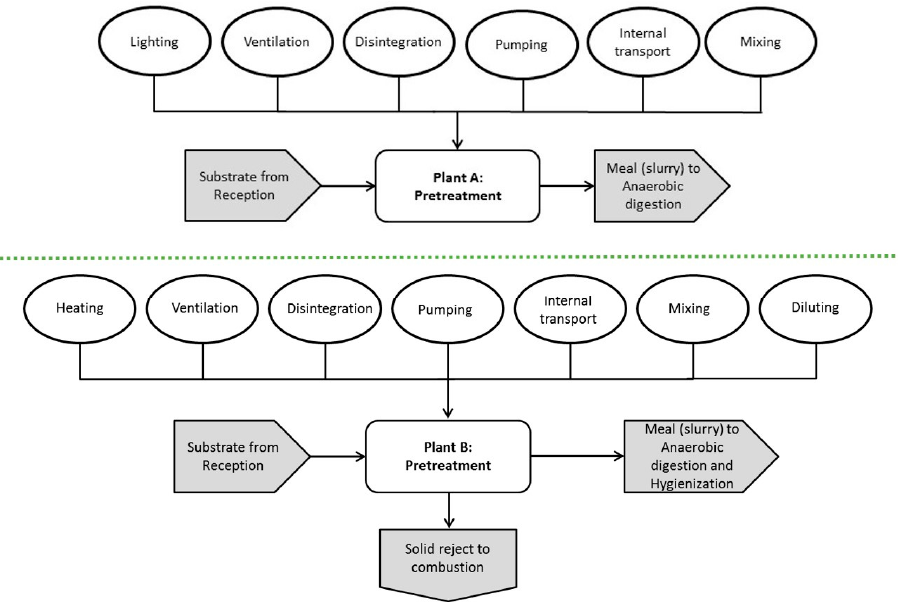
Figure 4. The connection between the sub-process pretreatment and unit processes at biogas plant A and B, respectively.